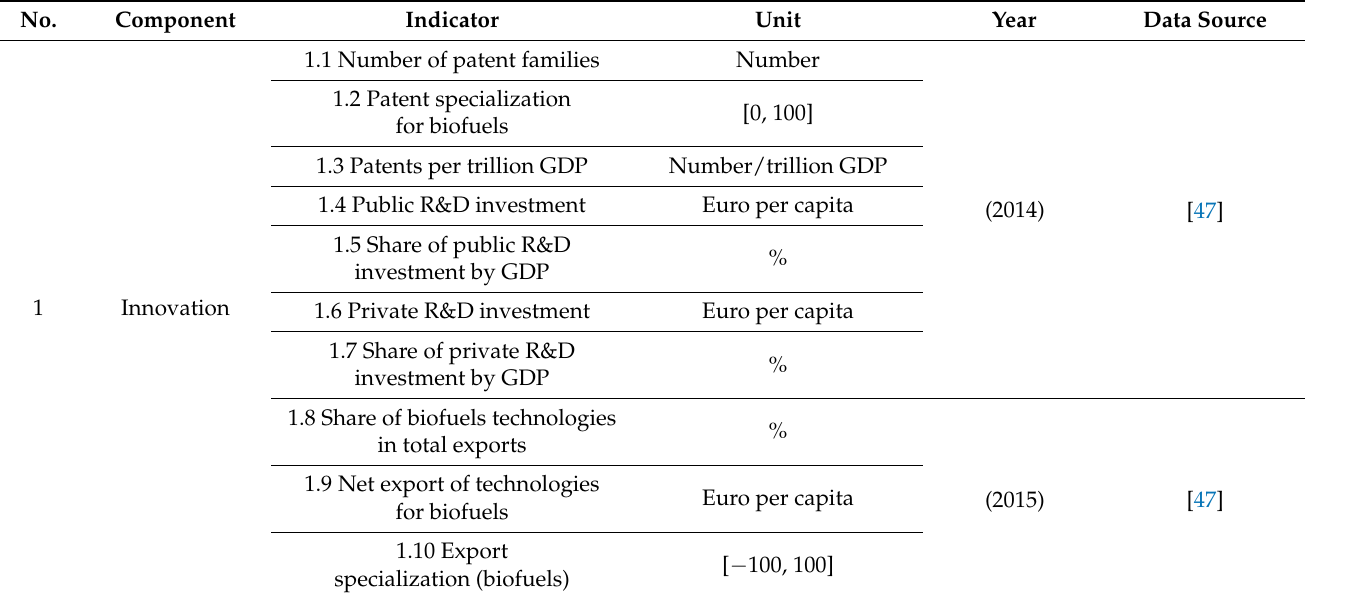
Table 1. Overview of the selected